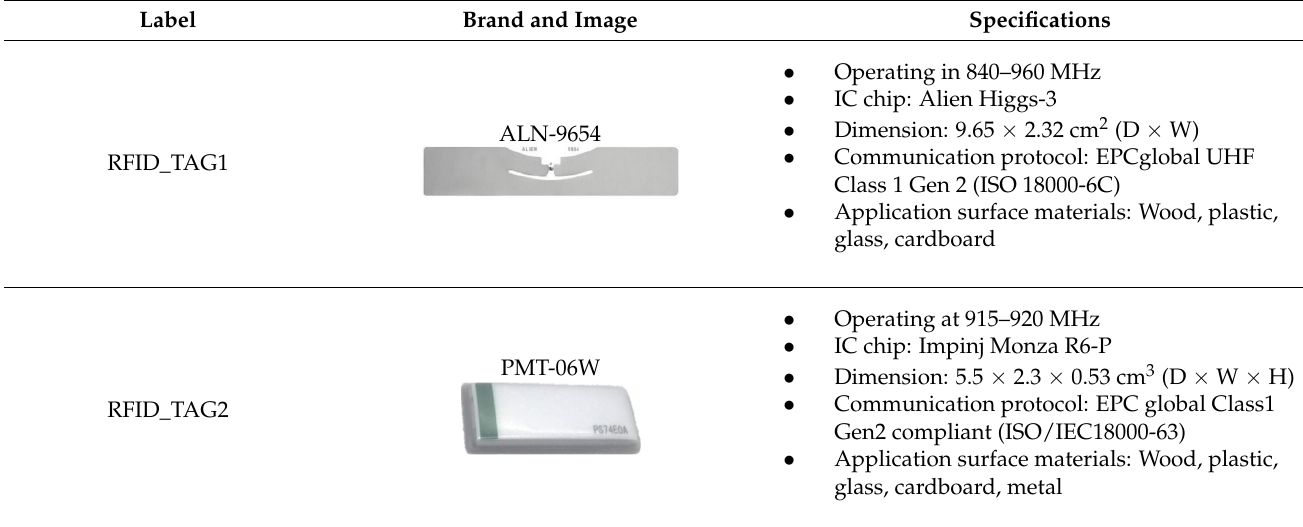
Table 5. RFID tags